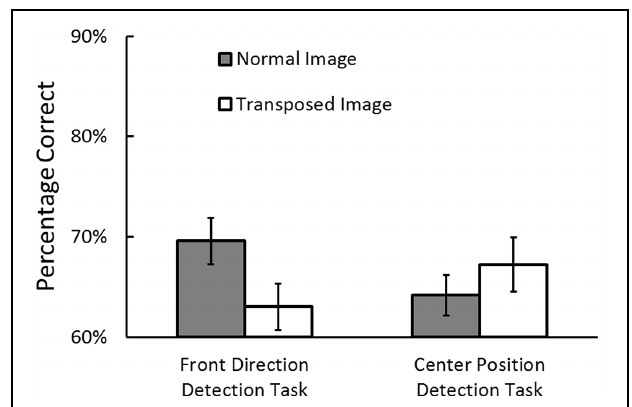
FIGURE 4 | Percentage of correct responses for the front direction detection task and center position detection task in Experiment 2. Error bars indicate standard